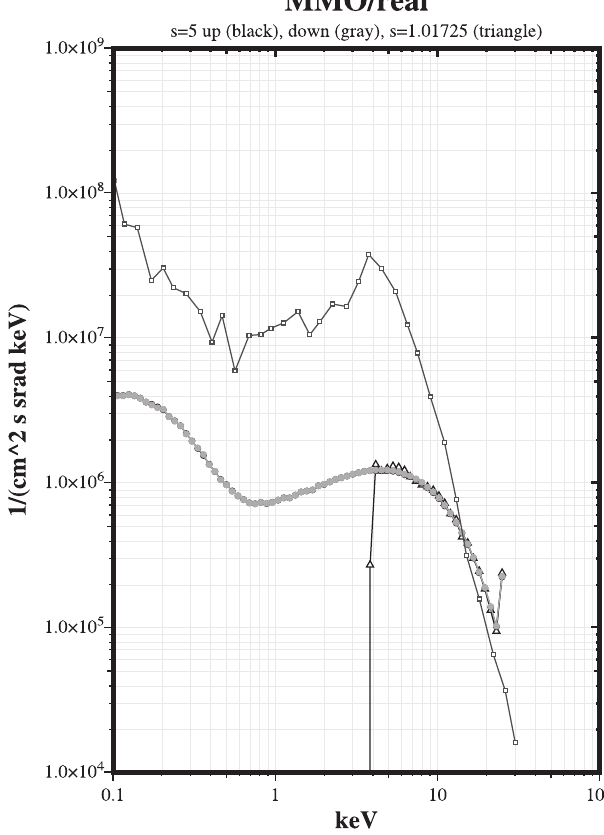
Fig. 15. MMO/real: same as model MMU (Fig. 13) but the particles now move through an O-shaped potential barrier instead of the U-shaped potential drop. The peak is